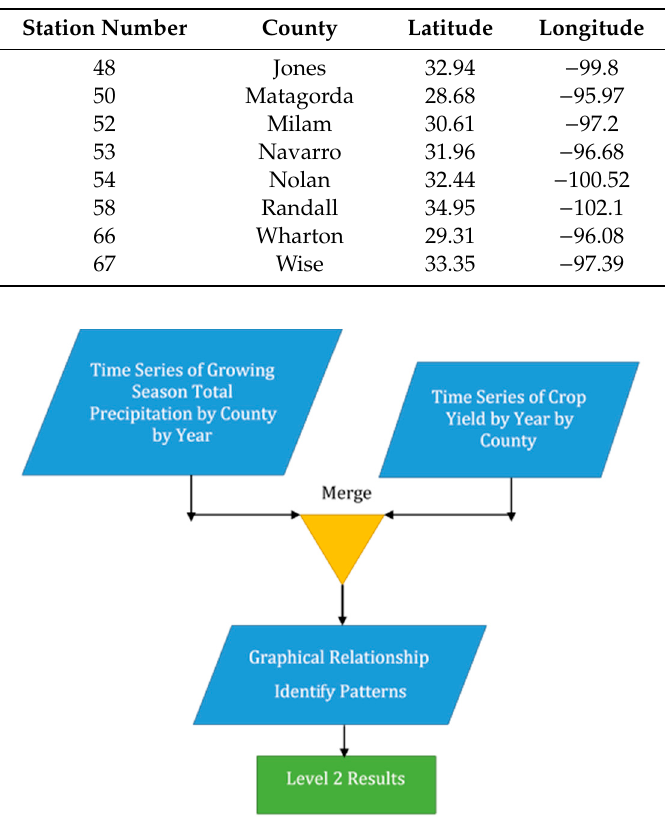
Figure A1. Generation of the graphical relationship between rainfed sorghum yield and growing season total precipitation (level 2 results).